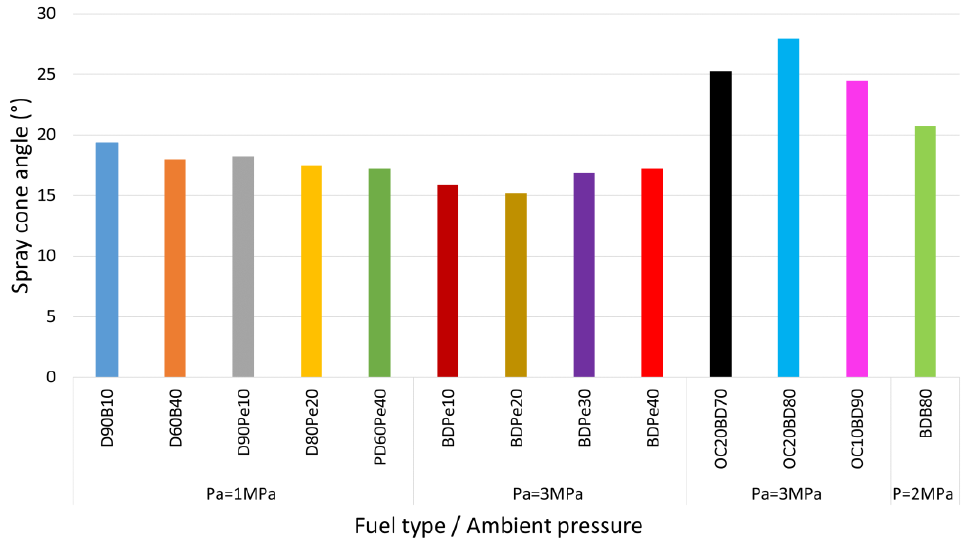
Figure 5. Spray cone angle for various fuel blends of butanol, pentanol, and octanol with diesel at 100 MPa injection pressure and three different ambient pressures [19,49,51,55].